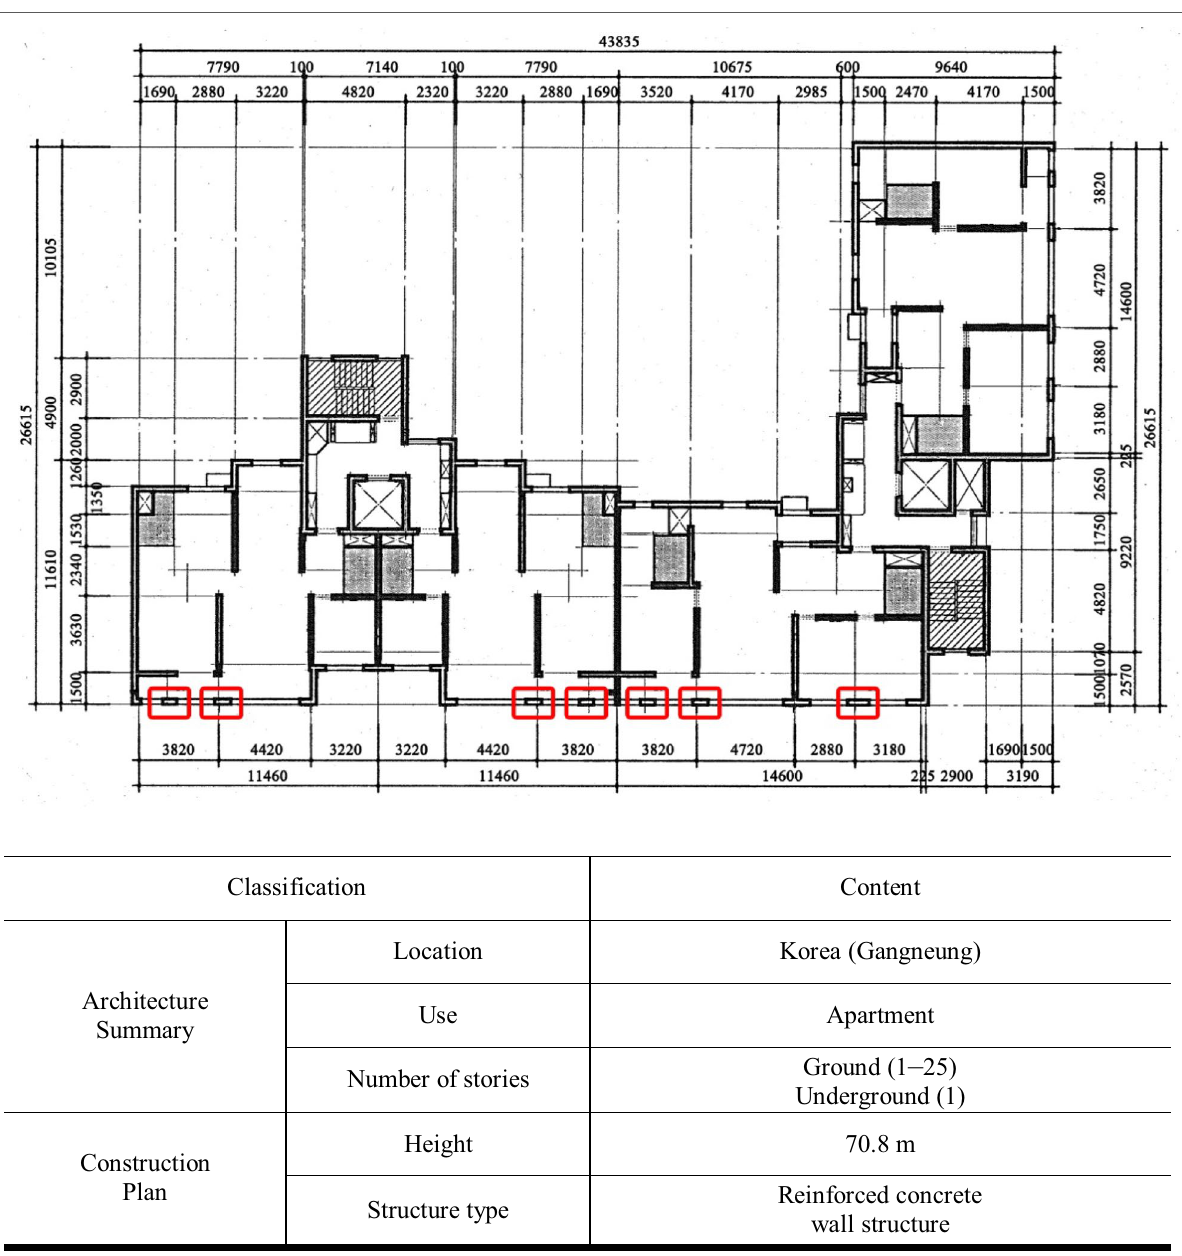
Fig. 3 Structural plan of wall‑type apartment (Case